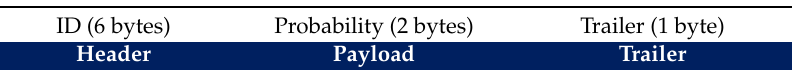
Table 3. Sensor node reply.